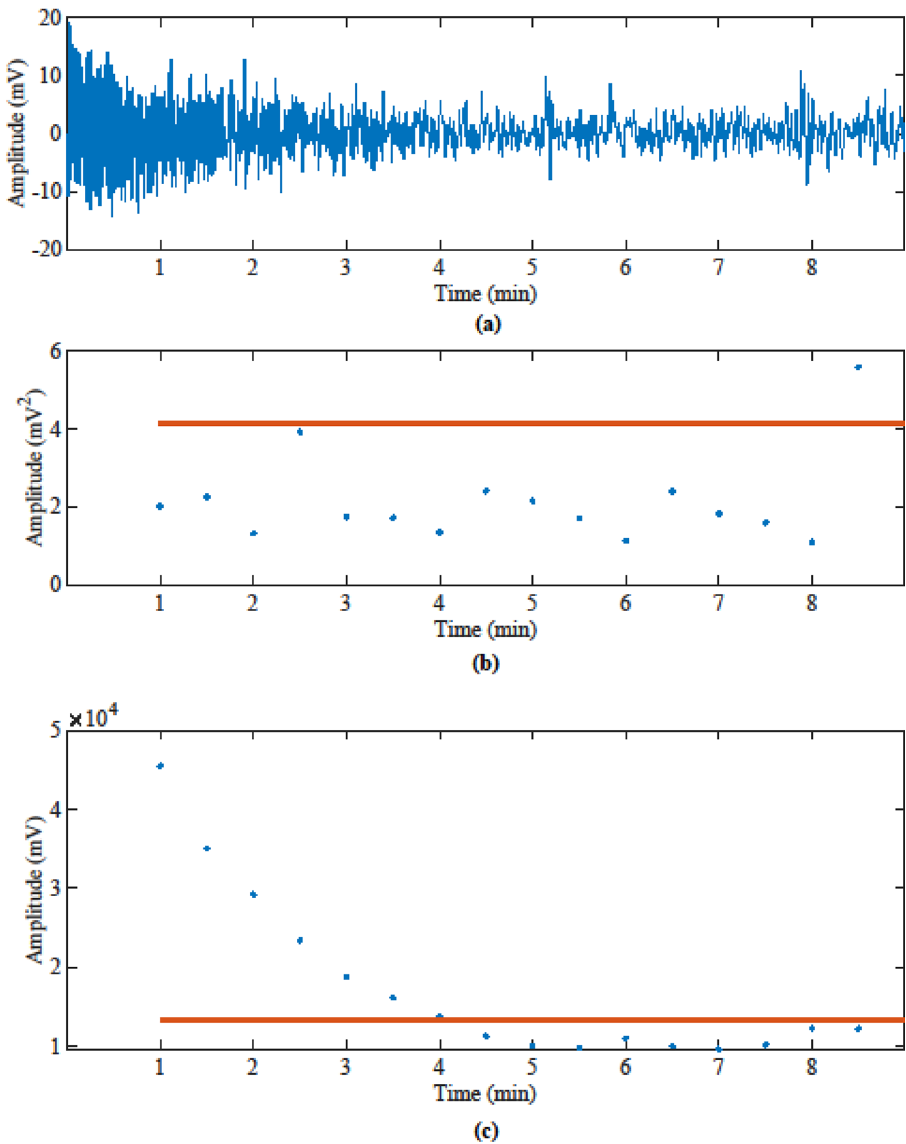
Figure 2. Vacancy detection of wall mounted TruePODS sensor for an empty room, using 1-min sliding- window with 30 s overlapping: ( a ) filtered radar signals after static-background being removed still contain a lot of noise outside the respiration band; ( b ) most of the noise is correctly discerned by BP method, which shows the room as vacant (blue dots below the red line indicate vacancy); ( c ) RI method cannot discern the large amplitude signal in the empty room potentially caused by vibration after plugging in the sensor and it reports false occupied signals for the first 4 min (where blue dots are above the red line) before correctly indicating vacancy (when blue dots drop below the red